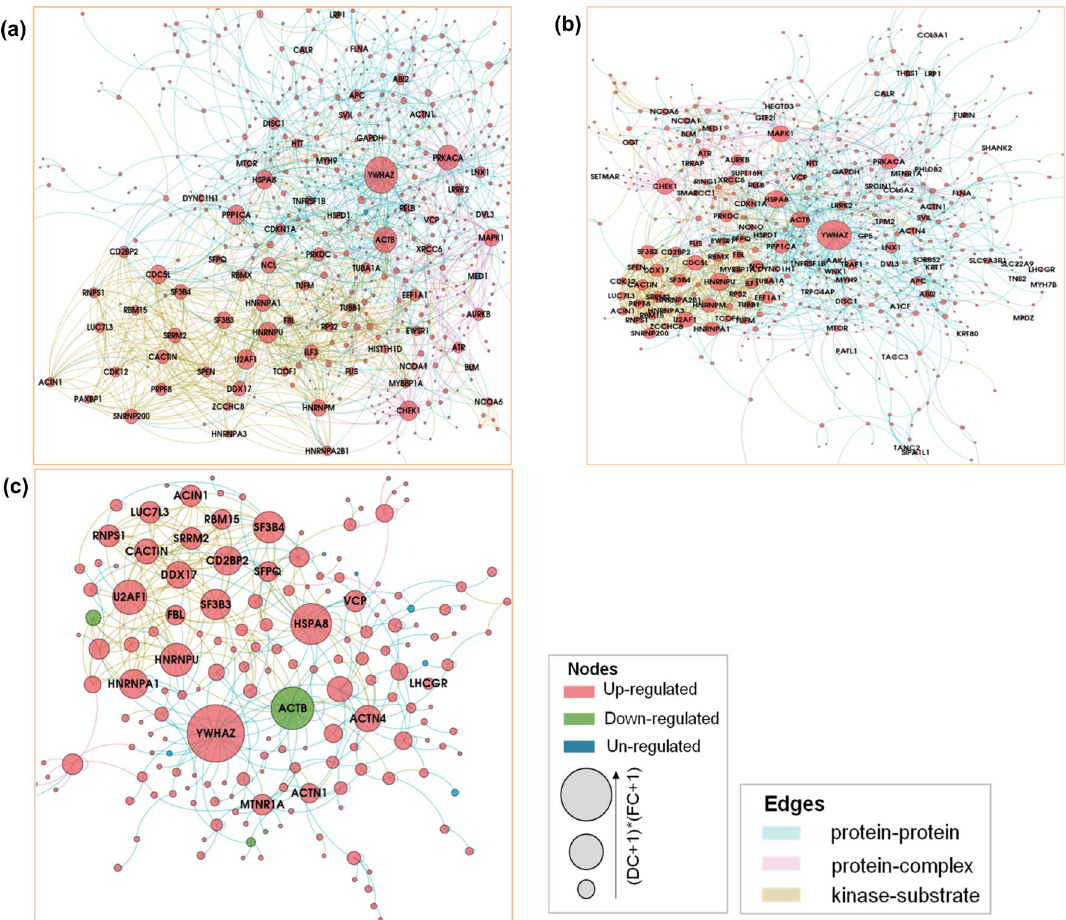
Figure 4. Protein–protein interaction network analysis of the differentially regulated proteins in the three HLNRA dose groups relative to NLNRA dose group. The Giant connected component (GCC) of protein– protein interaction network obtained from ( a ) Group II, ( b ) Group III, ( c ) Group IV HLNRA dose groups. The colours of the nodes indicate the modulation pattern (up-regulated, down-regulated, or un-regulated) of the proteins and the edges are coloured according to the source of the interaction. The network is laid out by multiplicative effect of fold change (FC) and Degree centrality (log2FC*Degree). High resolution portable network graphics (.png) versions of the interaction networks for Group II, Group III and Group IV HLNRA dose groups can be found as Supplementary Fig.